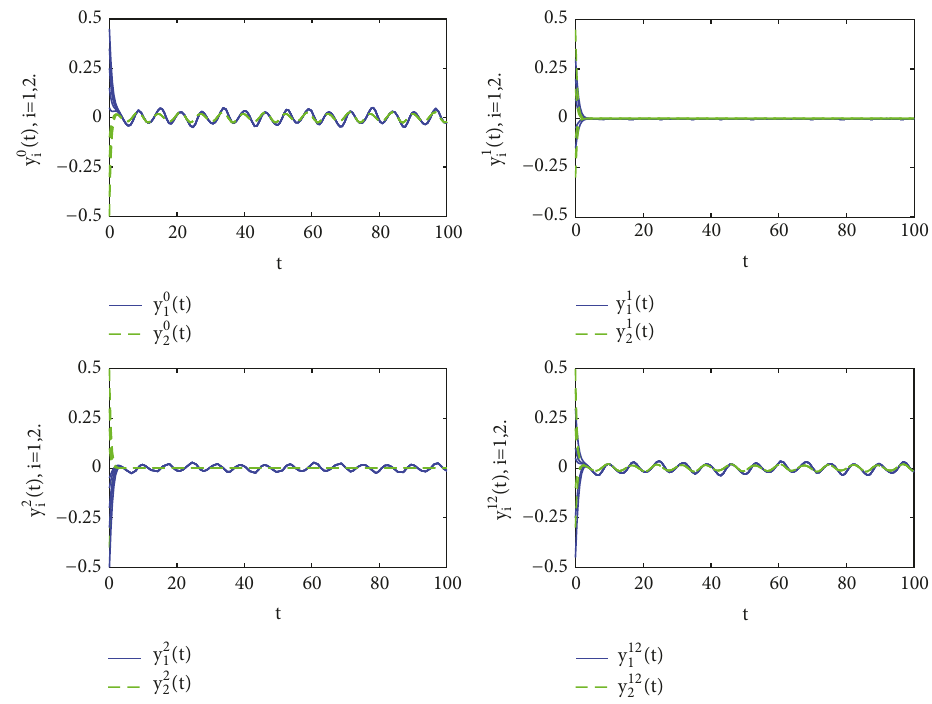
Figure 3: The states of 𝑦 0 (𝑡) , 𝑦 1 (𝑡) , 𝑦 2 (𝑡) , and 𝑦 12 (𝑡) in (43) under controller 𝑈(𝑡) .